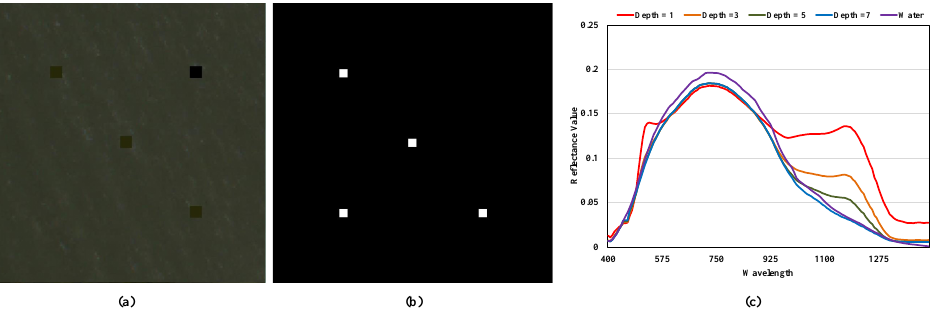
Figure 8. Synthetic data based on lake water for experiment. ( a ) Image scene of lake water; ( b ) distribu- tion of desired targets; and ( c ) spectra of desired targets and main backgrounds.